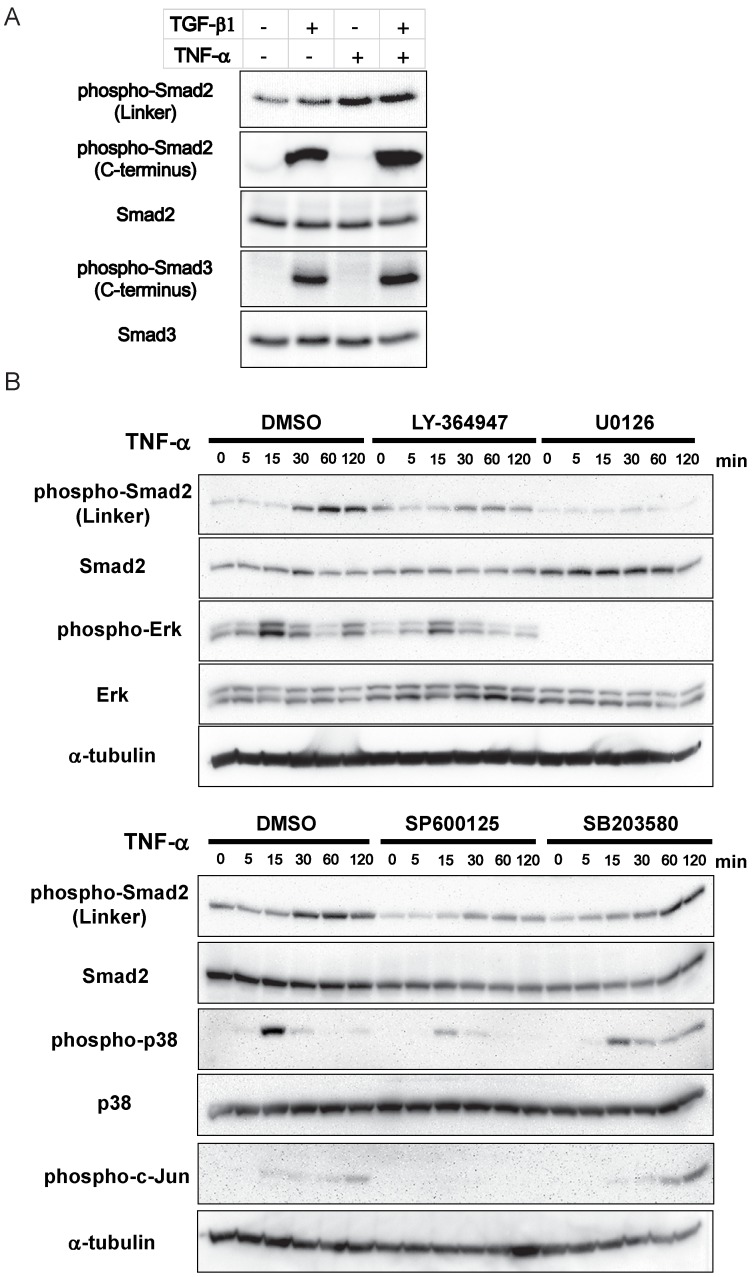
TNF-α phosphorylates Smad2 linker region via MEK-Erk and JNK pathways.(A) A549 cells were stimulated with TGF-β1 and/or TNF-α for 60 min and immunoblotting was performed for total Smad2, phosphorylated Smad2 (linker region: Ser 245/250/255), phosphorylated Smad2 (C-terminal region: Ser 465/467), total Smad3, phosphorylated Smad3 (C-terminal region: Ser 423/425). (B) A549 cells were pretreated with DMSO or chemical inhibitors (LY-364947, U0126, SP600125 and SB203580) for 60 min, followed by TNF-α stimulation. The cell lysates were collected at the indicated time points, and immunoblotting was performed for Smad2, phosphorylated Smad2 (linker region: Ser 245/250/255), Erk, phosphorylated Erk, p38, phosphorylated p38 and phosphorylated c-Jun. α-tubulin was used as loading control.